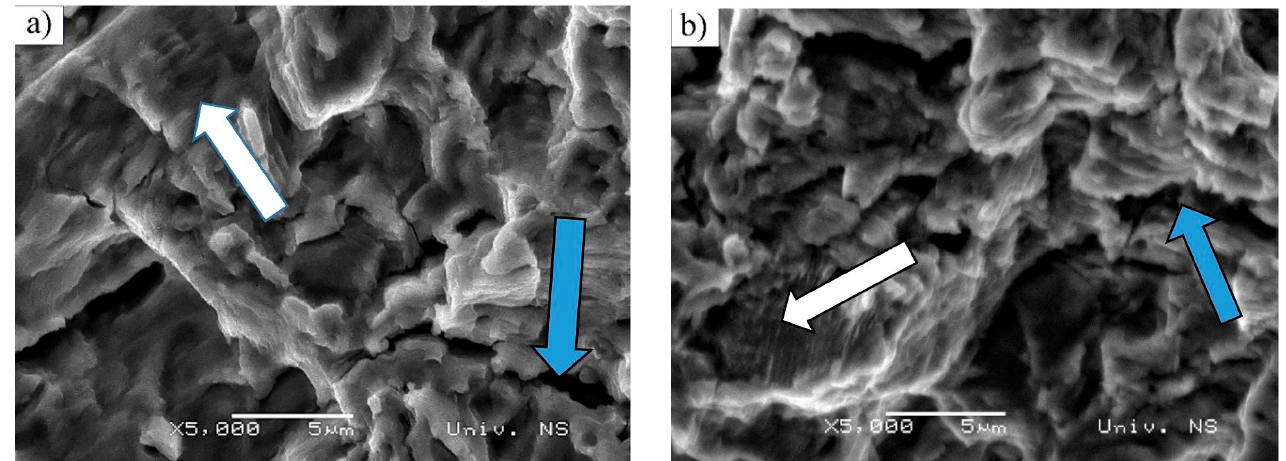
Figure 7. Fatigue crack propagation zone of tested steels—image taken using SEM microscope: ( a ) S235JRC+C steel and ( b ) C15E+C